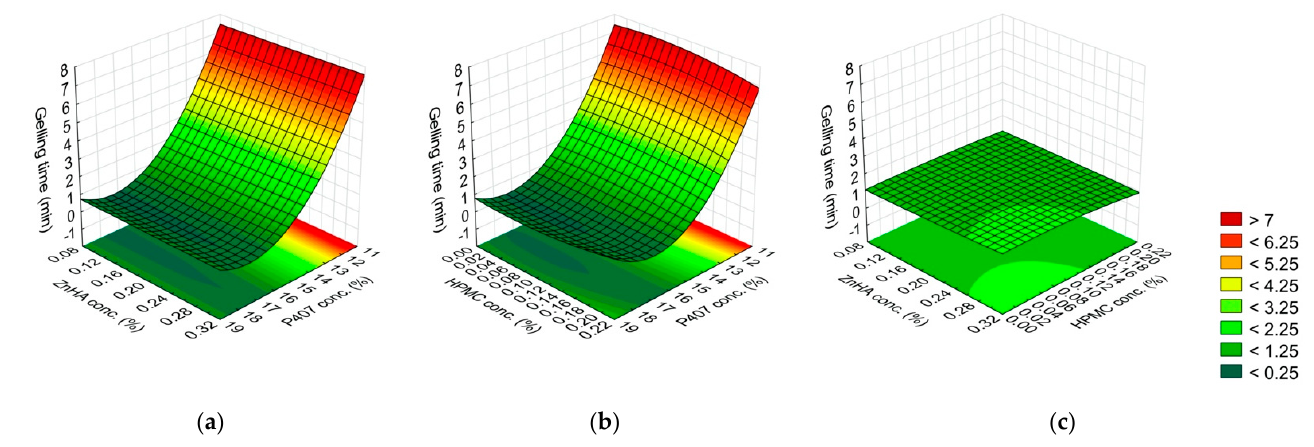
Figure 2. Effect of the composition on the gelling time: ( a ) P407 and ZnHA concentrations, ( b ) P407 and HPMC concentrations, ( c ) ZnHA and HPMC; (the 3rd factor is at 0 level in each case). The G ′ value was strongly determined by the P407 concentration (L, Q); however, the ZnHA concentration (L) and its interactions with other polymers (P407 (L) with ZnHA (L) and ZnHA (L) with HPMC (Q)) significantly decreases the gel strength (Figure 3, Table 4).